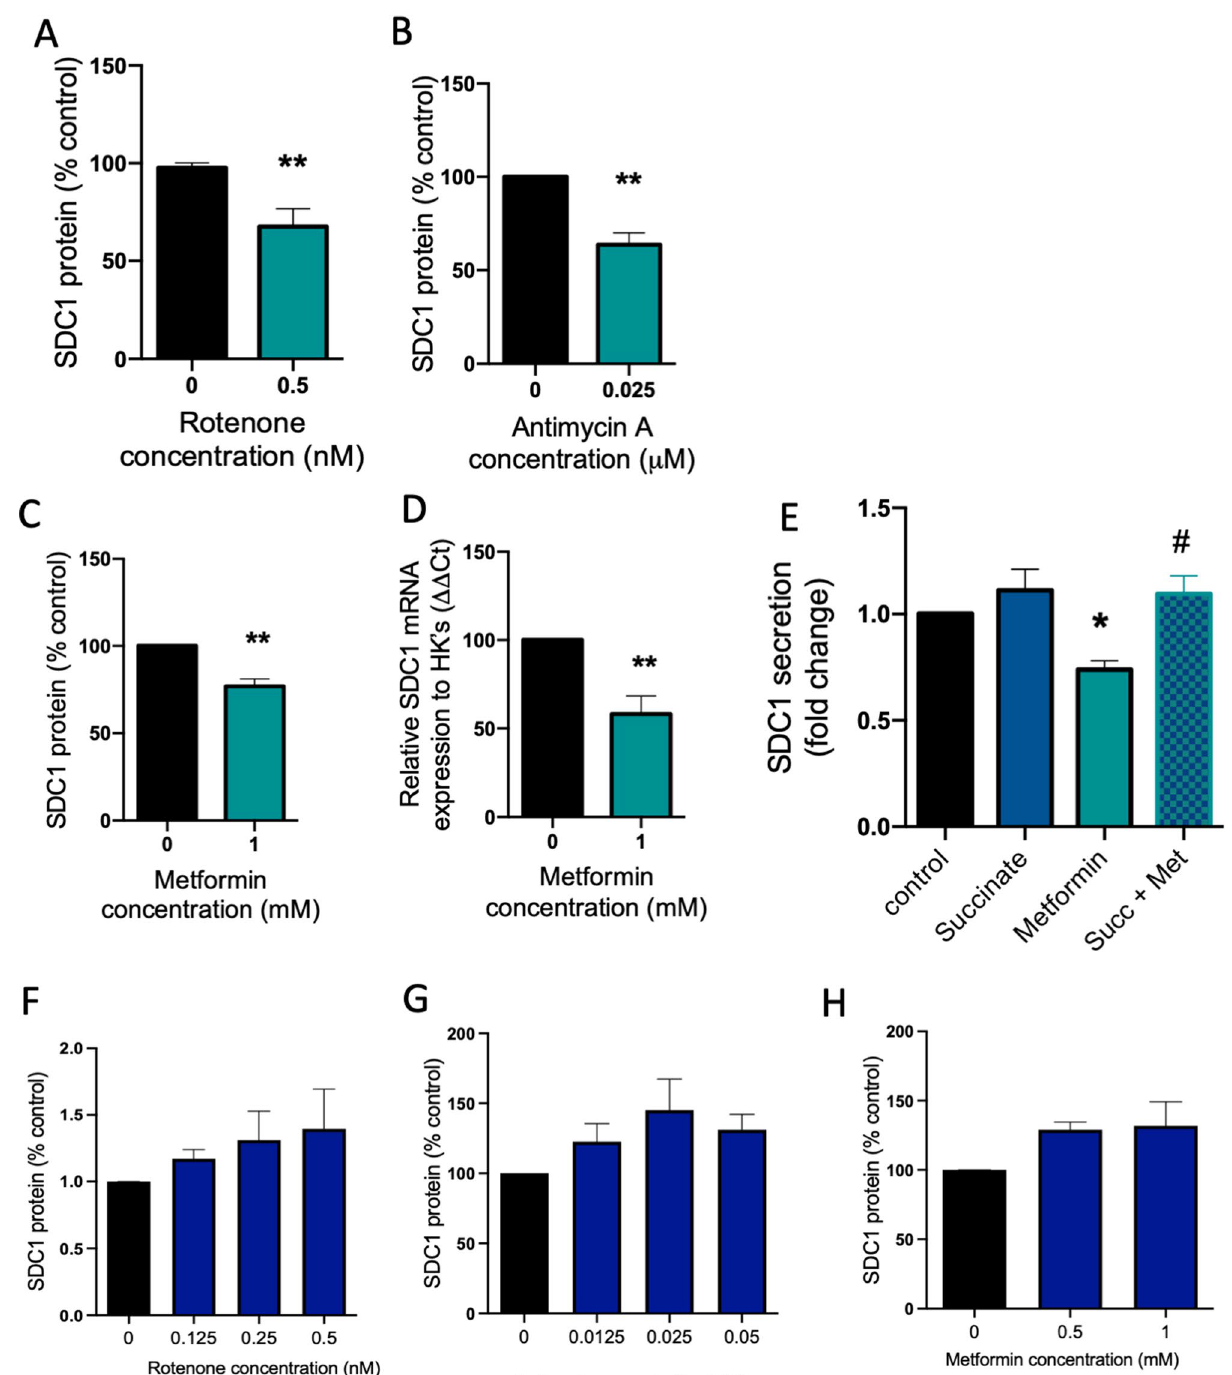
Figure 4. Soluble syndecan-1 may be regulated through the mitochondrial electron transport chain. Isolated primary trophoblast were treated with mitochondrial electron transport chain complex I inhibitor rotenone ( A ) or complex III inhibitor antimycin A ( B ). Low doses of both caused a significant reduction in syndecan-1 secretion. Similarly, when isolated cytotrophoblast were treated with mitochondrial electron transport chain complex I inhibitor metformin, syndecan-1 secretion was significantly reduced ( C ) as well as syndecan-1 mRNA expression ( D ). Isolated primary cytotrophoblast were also treated with complex I inhibitor metformin in the presence of complex II activator succinate. Whilst metformin significantly reduced syndecan-1 secretion, this effect was reversed when succinate was added ( E ). Contrary to term cytotrophoblast, no effect on syndecan-1 secretion was observed following treatment with rotenone, antimycin or metformin in syncytialised cytotrophoblast stem cells ( F – H ). Data is expressed as mean ± SEM. *p < 0.05, **p < 0.01, relative to control, # p < 0.05 relative to metformin treated